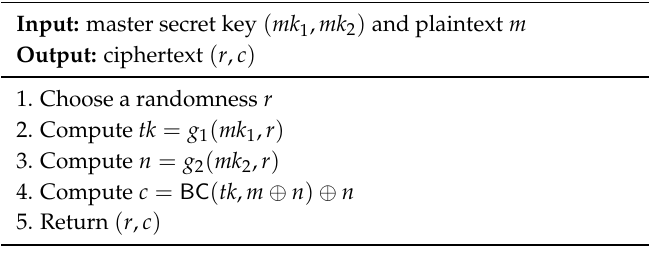
Algorithm 1 First-order SCA-resistant re-keying scheme: enc 1